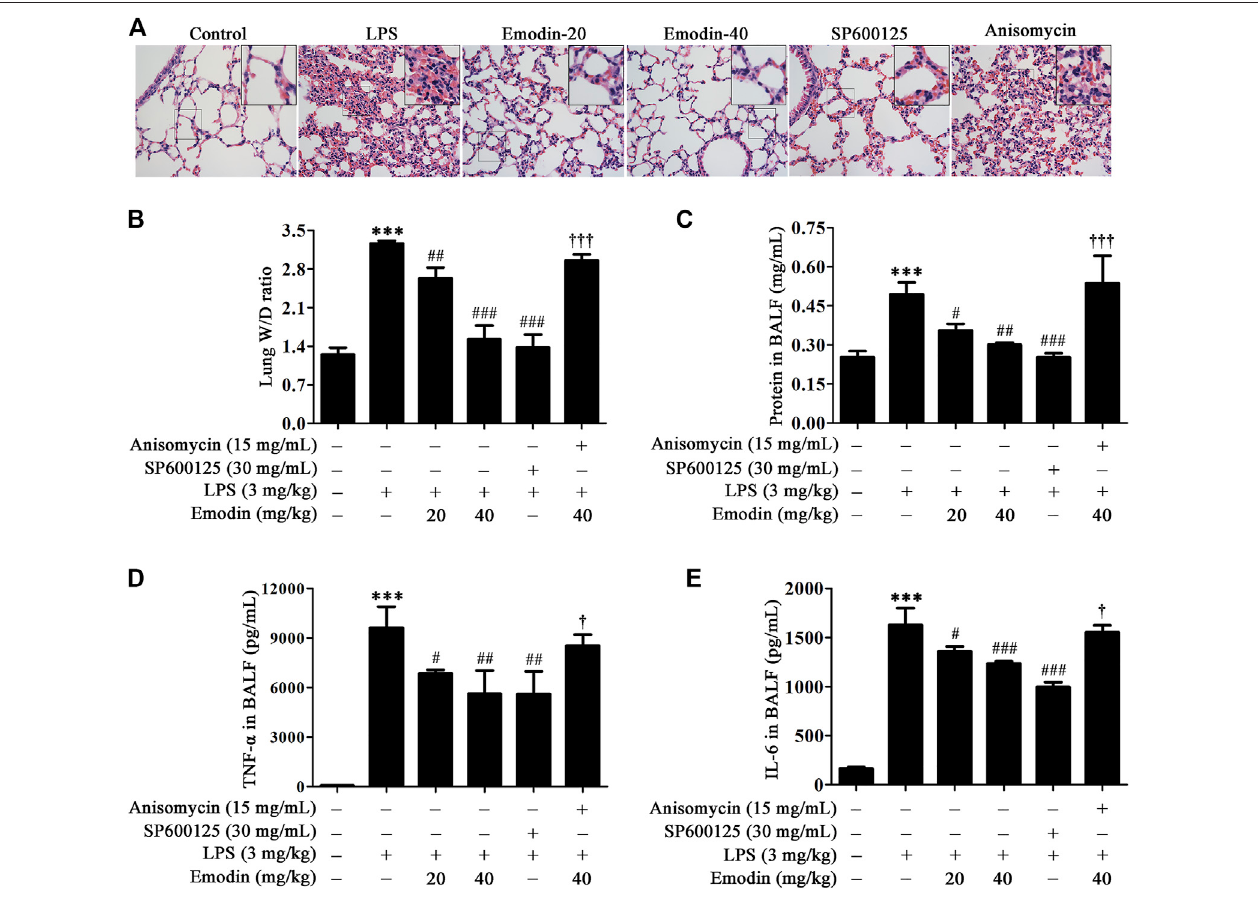
FIGURE 5 | Emodin inhibits LPS-induced acute lung injury (ALI) in mice via the JNK pathway. (A) SP600125 alleviates the protective effects of emodin on lung histopathological changes in ALI mice. The lung tissues were stained with hematoxylin and eosin (H&E) (40 ×). ( B – E) Anisomycin counteracts the inhibitory effects of emodin on in fl ammation and edema in ALI mice. At 8 h after stimulation by LPS, lung tissues were separated and then weighted to obtain the W/D ratio (B) . BALF was collectedtodetectthetotalproteinconcentration (C) usingtheBCAproteinassaykit,andthelevelsofTNF- α (D) andIL-6 (E) inthesupernatantweremeasuredby ELISA.Dataarepresentedasmean±SEM, n =8.*** p < 0.001comparedwiththecontrolgroup; # p < 0.05, ## p < 0.01, ### p < 0.001comparedwiththeLPSgroup; † p < 0.05, ††† p < 0.001 compared with the emodin-40